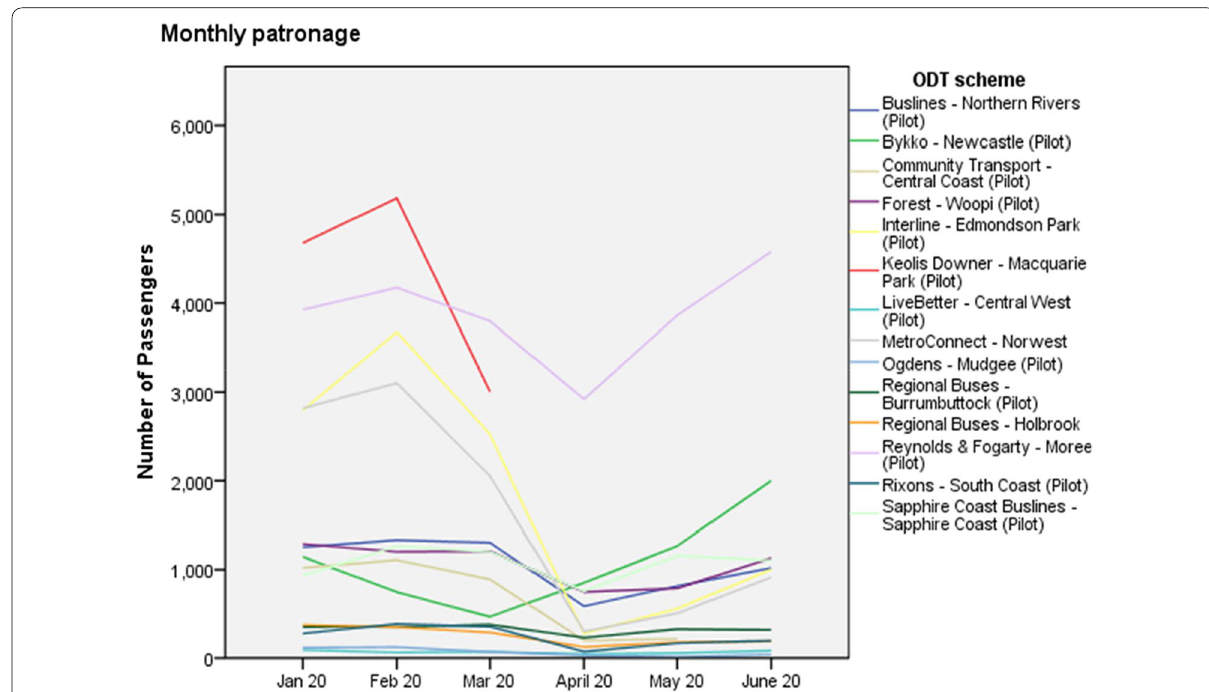
Fig. 3 ODT patronage trends, Jan–June 2020 ( Source TfNSW Open Data Hub). Note The two largest schemes by patronage are excluded: Keolis Northern Beaches with monthly patronage in June around 10,000; pre-COVID-19 levels were around 18,000 passengers / month; and Cooee—The Ponds with monthly patronage in June around 5000 and pre-COVID-19 levels of around 10,000. Macquarie Park ceased operation in March 2020 as